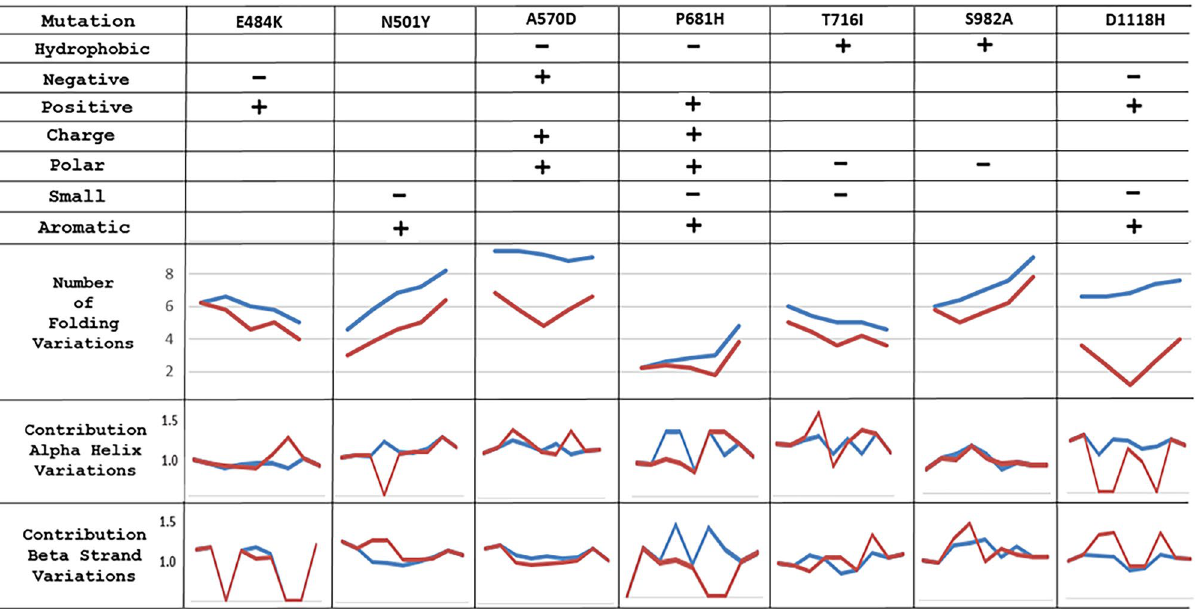
Table 6. The variations of physiochemical properties and folding features for Alpha variant. Alpha variant is compared with GenBank QTJ15692.1 of SARS-CoV-2 as reference. The potential changes of physiochemical properties are listed on top seven rows, the “−” means a specific property decreased after mutation and the “+” property increased after mutation. The folding variations are listed at bottom three rows. The red curves represented the status after mutations; blue curves for status before